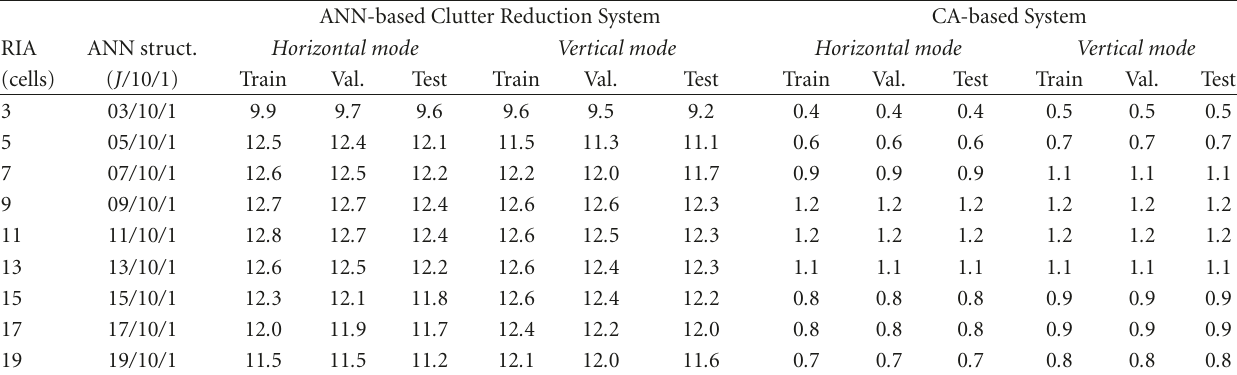
Table 2: Performance evaluation ( SCR av,imp (dB)) of CA- and ANN-based clutter reduction systems with di ff erent number of integrated cells, J , considering 1D integration modes. ANN-based Clutter Reduction System CA-based